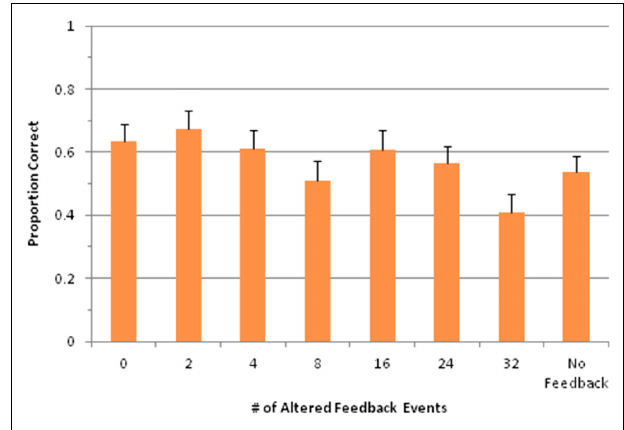
FIGURE 6 | Proportion of correct answers in the load task for each feedback condition. Error bars represent 1 SE of the